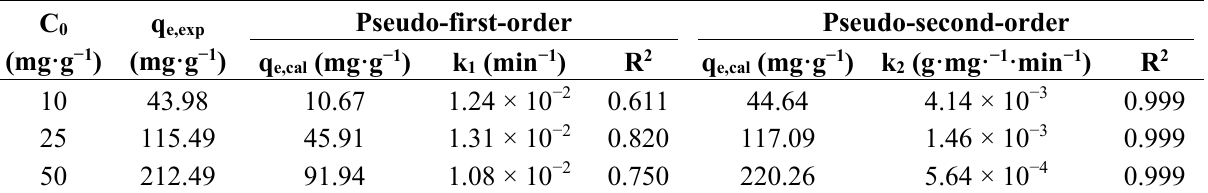
Table 3. Kinetic parameters for the adsorption of Orange II over Fe(BTC) at different concentrations (adsorbent mass: 10 mg; temperature: 308 K; pH 7).